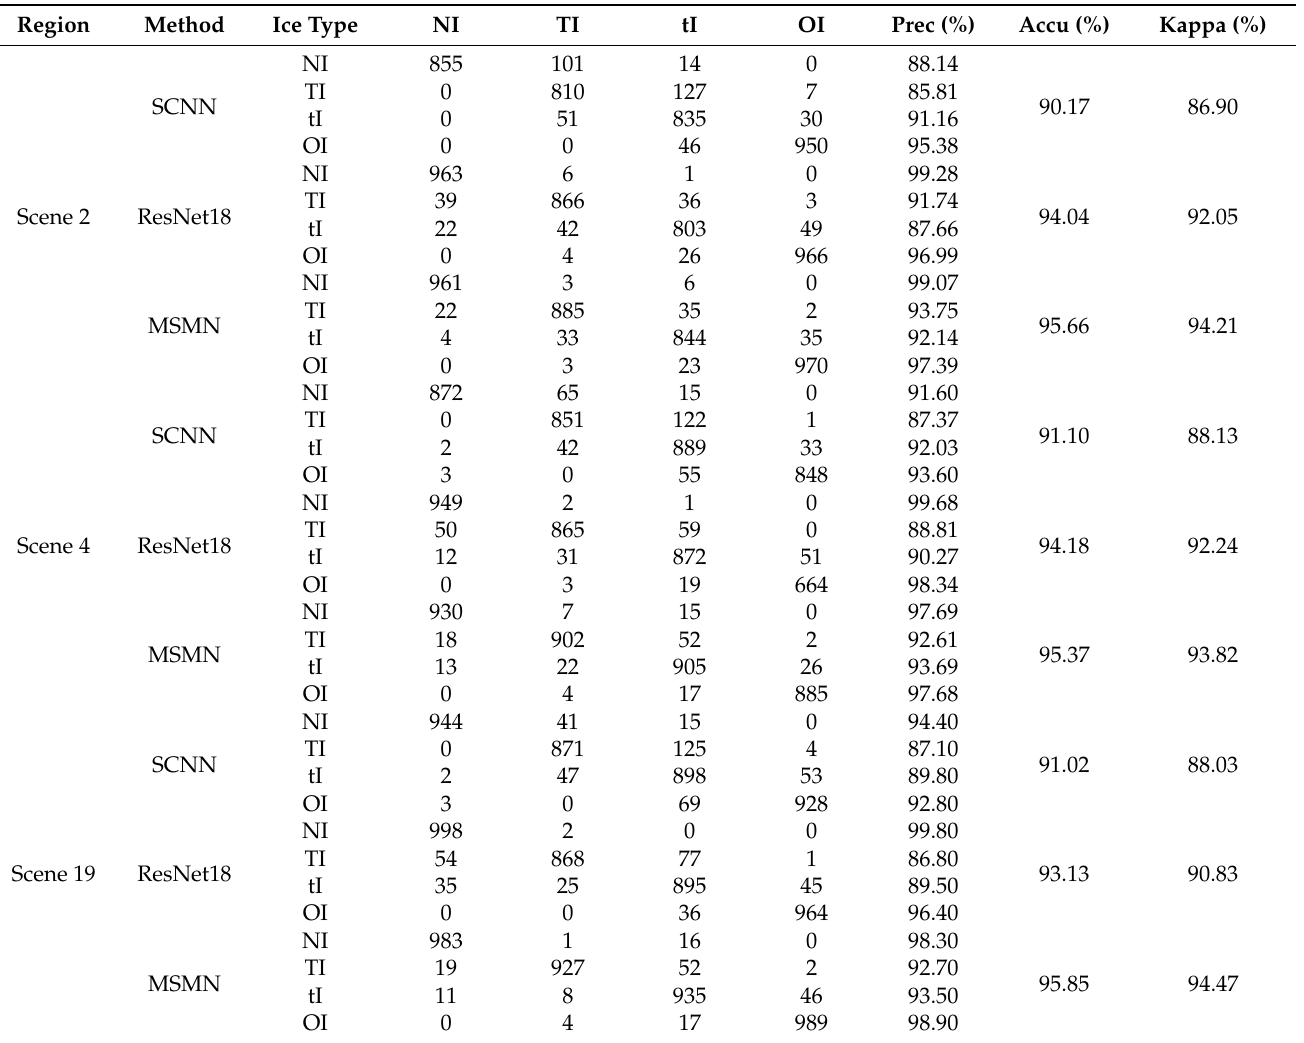
Table 6. Sea ice classification confusion matrix using three classification algorithms in three